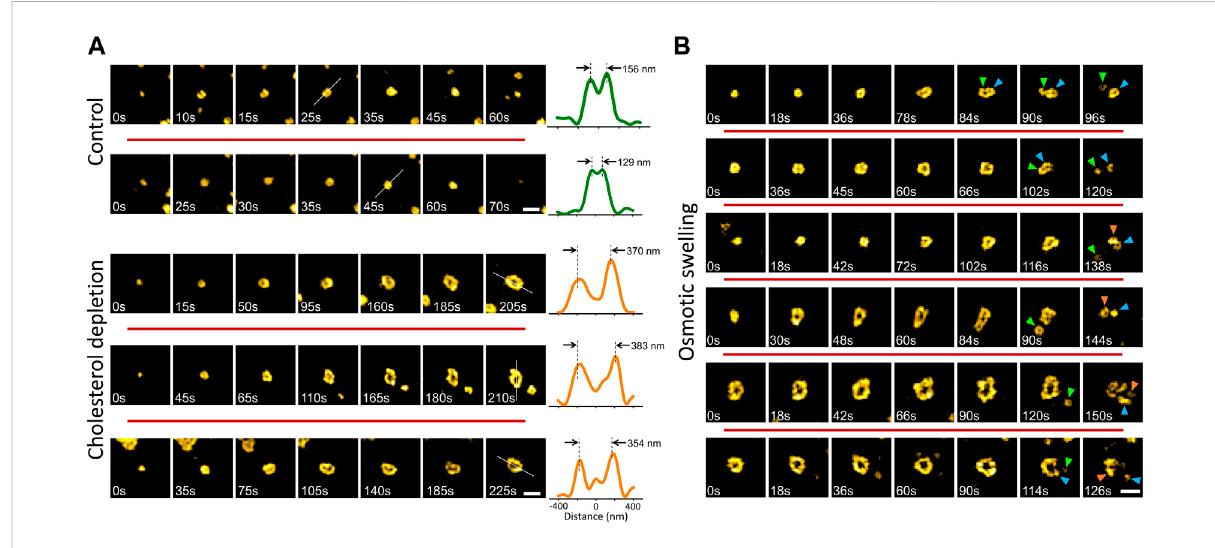
FIGURE 3 Formation and dissolution of giant coated pits (GCPs) in cultured cells. (A) Examples (in different rows) of canonical CP formation detected in live SUM159 cells expressing clathrin-mRuby (upper). Cholesterol depletion by methyl- β -cyclodextrin (M β CD) treatment induces GCP formation in the same cell line (lower). For each structure, the intensity pro fi le along the dashed line is plotted on the right. Peak-to-peak distances demonstrate thesizedifferencebetweenCPsandGCPs. (B) Examples(indifferentrows)ofGCPformationanddissolutiondetecteduponhypotonicswelling in SUM159 cells genome edited to express AP2-EGFP. Arrowheads in different colors mark segments separated from the GCPs. Scale bars, 0.5